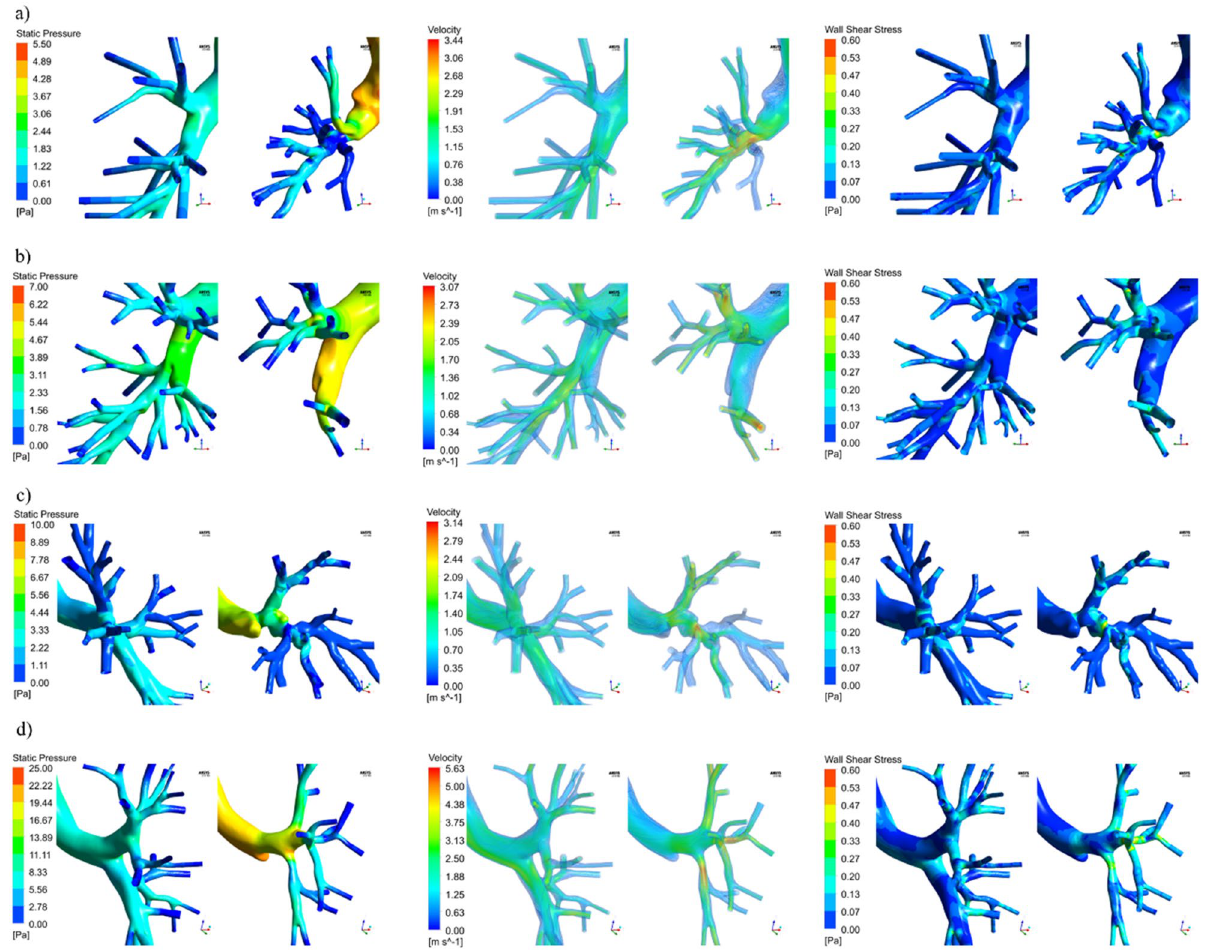
Figure 3. Contours of wall pressure (left), velocity streamlines (middle), contours of wall shear stress for four representative subjects in the proximity of the surgery site. ( a ) subject 2, right upper pulmonary lobectomy; ( b ) subject 6, right lower pulmonary lobectomy; ( c ) subject 9, left upper pulmonary lobectomy; ( d ) subject 12, left lower pulmonary lobectomy (Fluent v16, CFD-Post v16-Ansys, www. ansys.